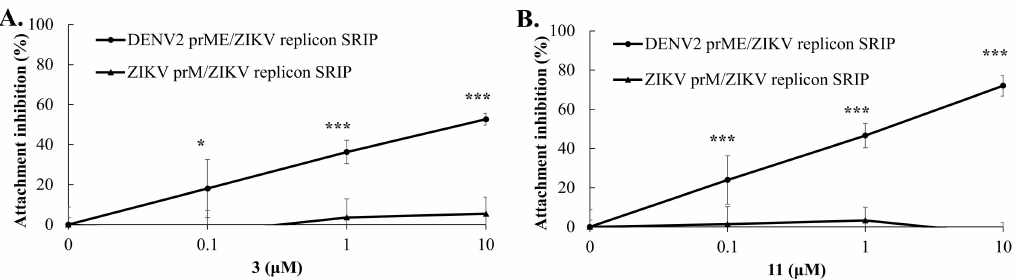
Figure 7. Attachment inhibition of chimeric DENV2 prM-E/ZIKV and wild-type ZIKV SRIPs by active GL derivatives 3 and 11 . Vero E6 cells were pre-cooled and incubated with fresh-prepared mixtures of DENV2 prM-E/ZIKV or wild-type ZIKV SRIPs, with active GL derivatives 3 ( A ), and 11 ( B ) at 4 ◦ C for 1 h, respectively. After the removal of the mixtures, the cells were kept at 37 ◦ C for 18 h and then an immunofluorescent assay with anti-ZIKV NS1 antibodies plus DAPI staining was performed. Finally, the inhibition percentage of SRIP attachment infectivity was measured as follows: 1-(percentage of ZIKV NS1 positivity in treated cells/ percentage of ZIKV NS1 positivity in mock-treated cells). * p < 0.05; *** p < 0.001 compared with untreated, infected